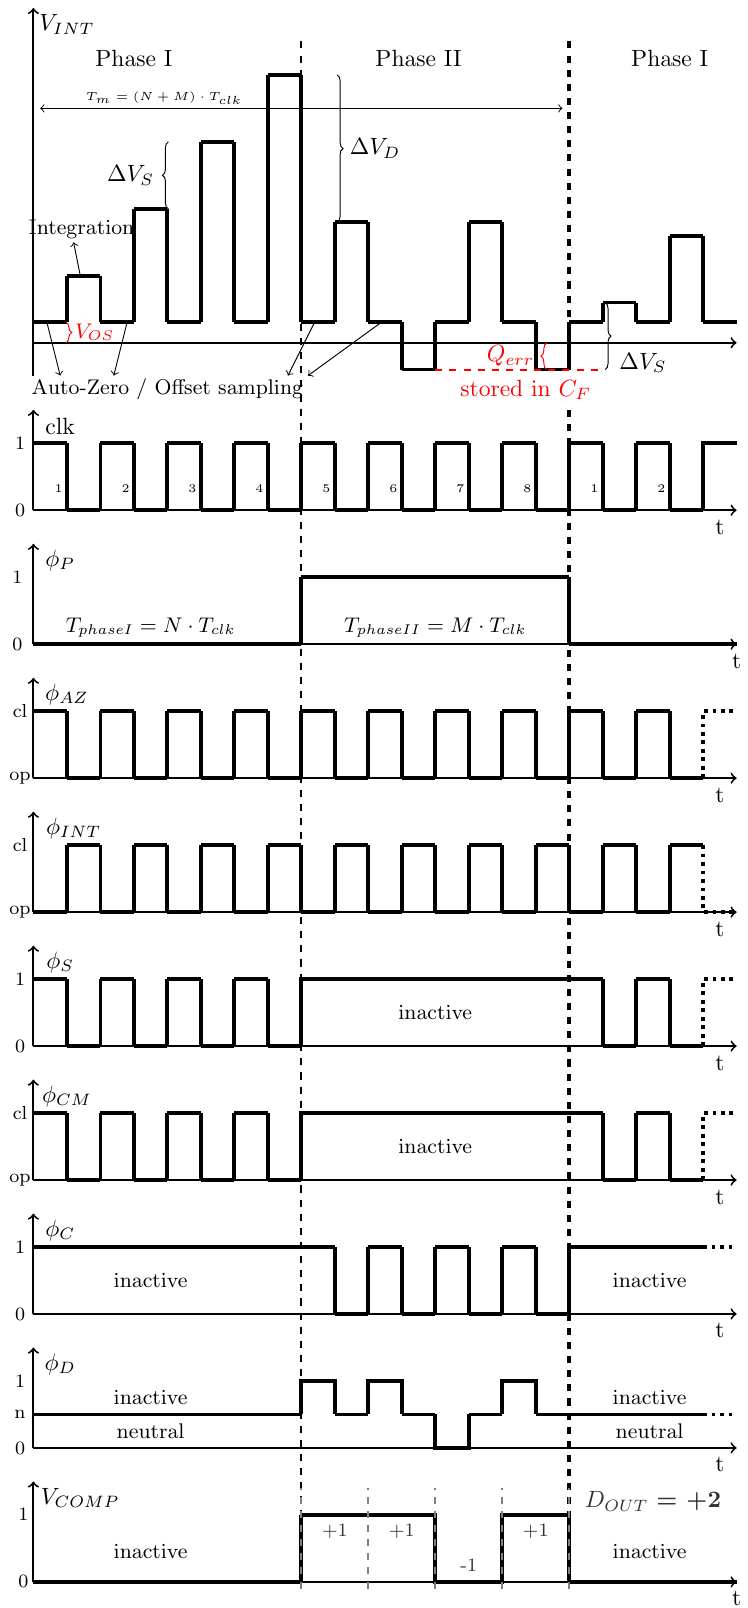
Figure 9. Implemented timing diagram and data evaluation of N = M = 4. Note: Non-overlapping signals are not shown and infinite OTA settling speed is assumed for more